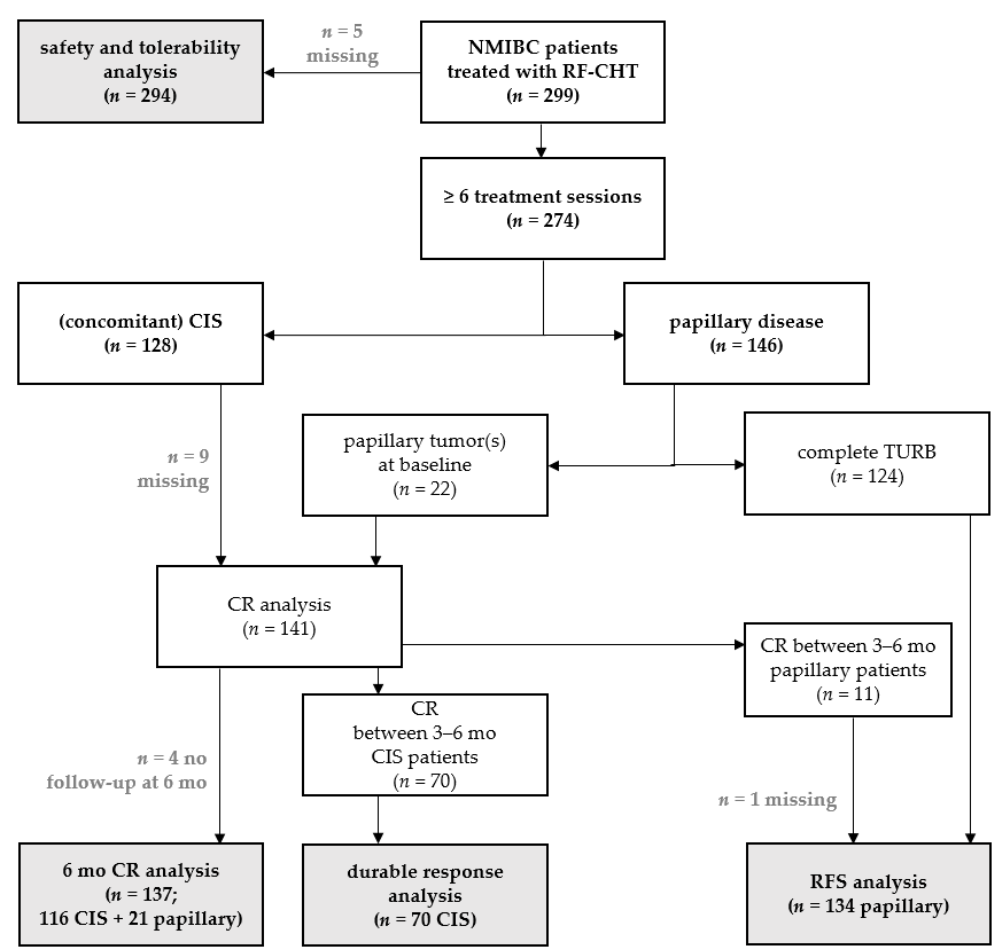
Figure 1. Flow-chart for this retrospective study including all non-muscle invasive bladder cancer (NMIBC) patients treated with RF-CHT.